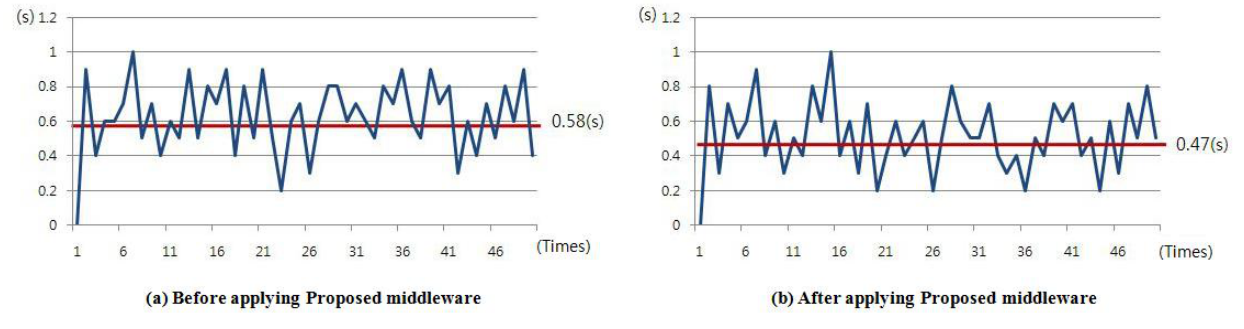
Figure 20. Average response time for user’s